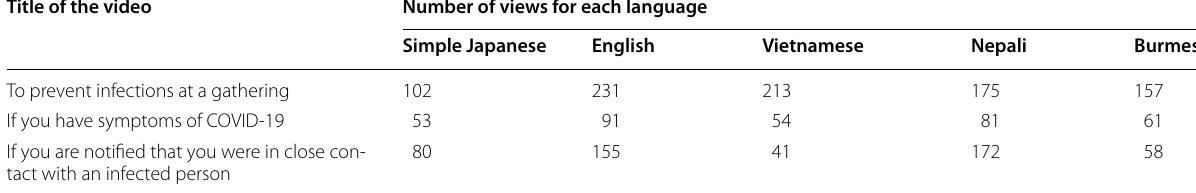
Table 4 Numbers of views of three videos in five languages